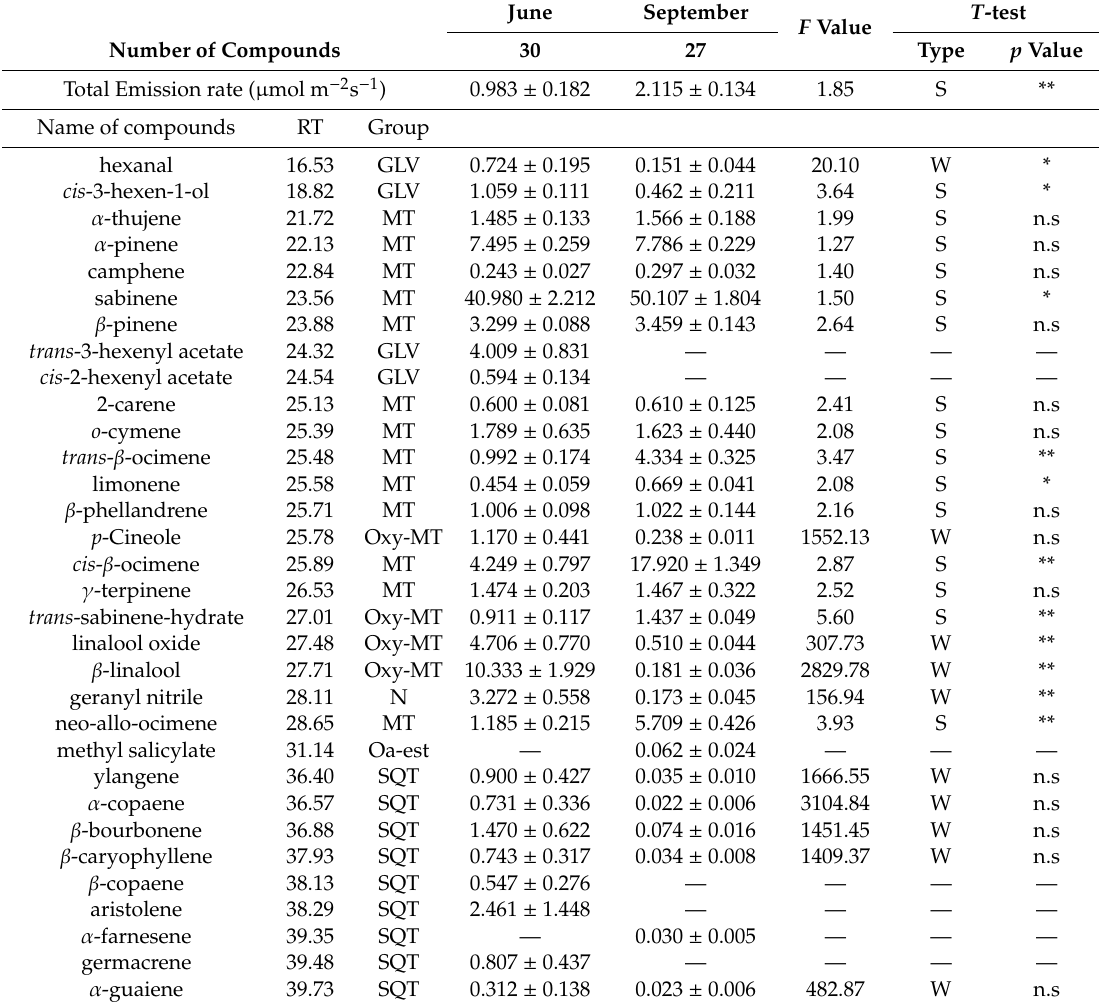
Table 3. Biogenic volatile organic compounds’ (BVOCs) Composition rates (%) of leaves of Japanese white birch at compounds